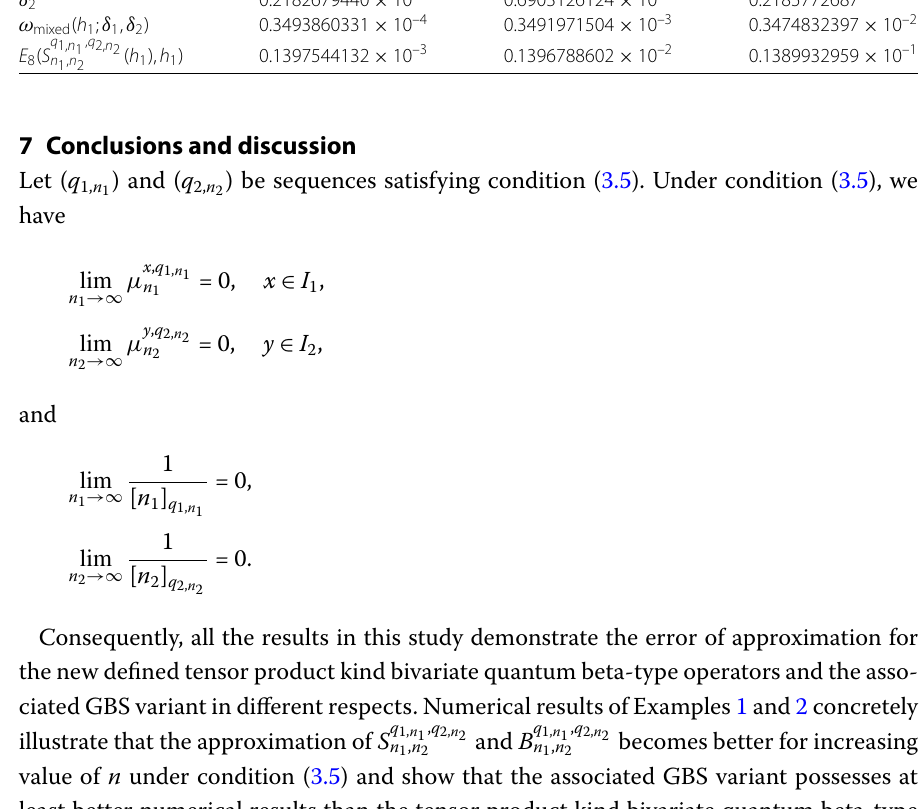
q 1, n 1 , q 2, n 2 n 1 , n 2 ( h 1 ) to h 1 by means of the mixed modulus